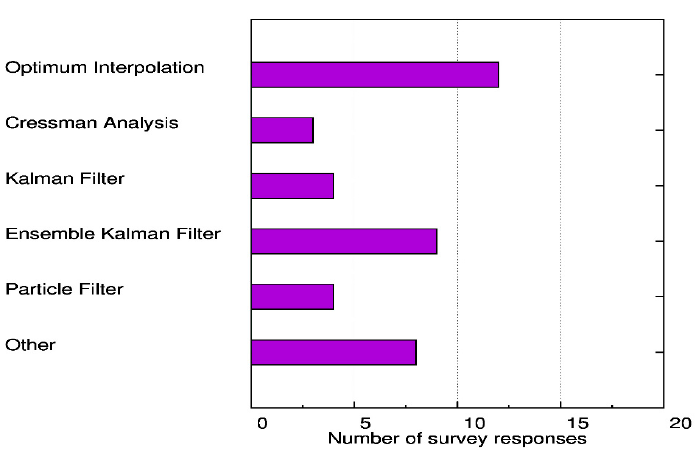
Figure 3. Data assimilation Figure 3. Data ass imilation methods.